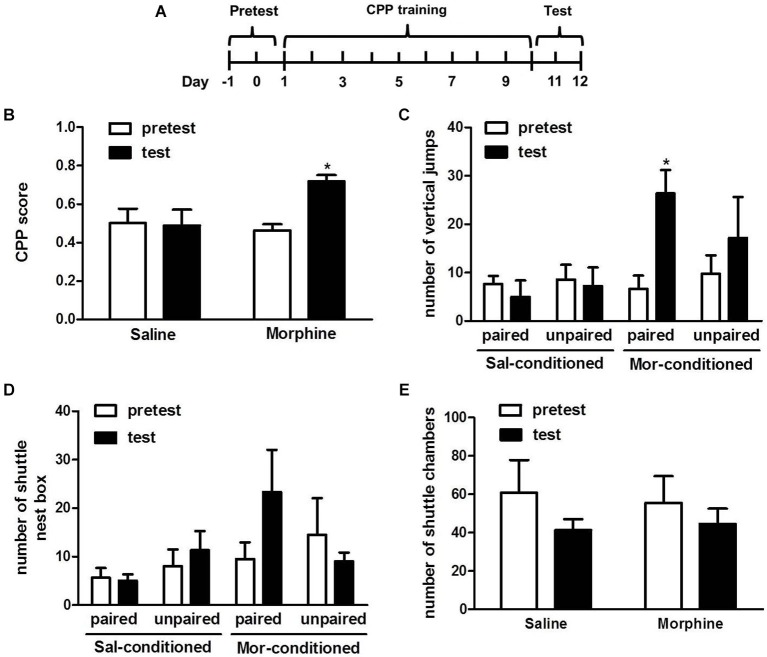
Effects of morphine on the induction of conditioned place preference. (A) Diagram outlining the behavioral procedures. (B) Tree shrews that received alternating injections of morphine and saline showed a significant preference for the morphine-paired chamber. (C) The vertical jump number of the morphine-conditioned tree shrews in the morphine-paired chamber significantly increased on the test day. (D) The amount of shuttles between the cage and nest box of morphine-conditioned tree shrews in the morphine-paired chamber had an increasing trend on the test day. (E) The amount of shuttles between the two chambers of morphine- and saline- conditioned tree shrews had no change. Blank and solid columns represent data from pre- and post-conditioning tests, respectively. * p < 0.05, pretest vs. test. The data are expressed as means ± SEM, and analyzed using two-way ANOVA followed by Bonferroni post hoc test, n = 5–6.